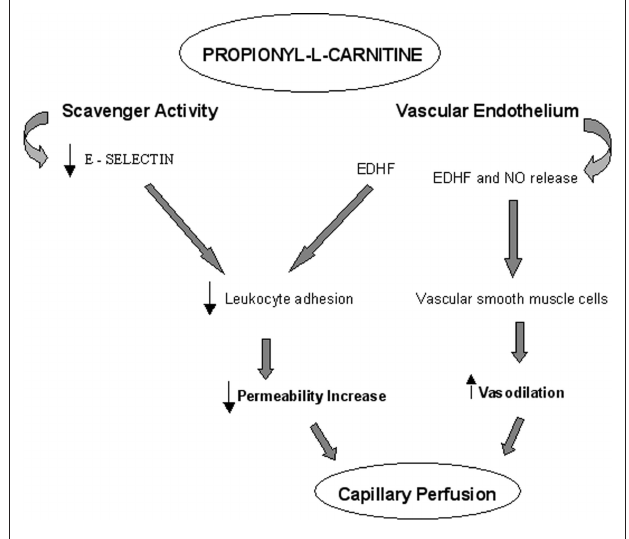
FiGuRE 8 | Scheme of mechanisms triggered by pLc during ischemia–reperfusion